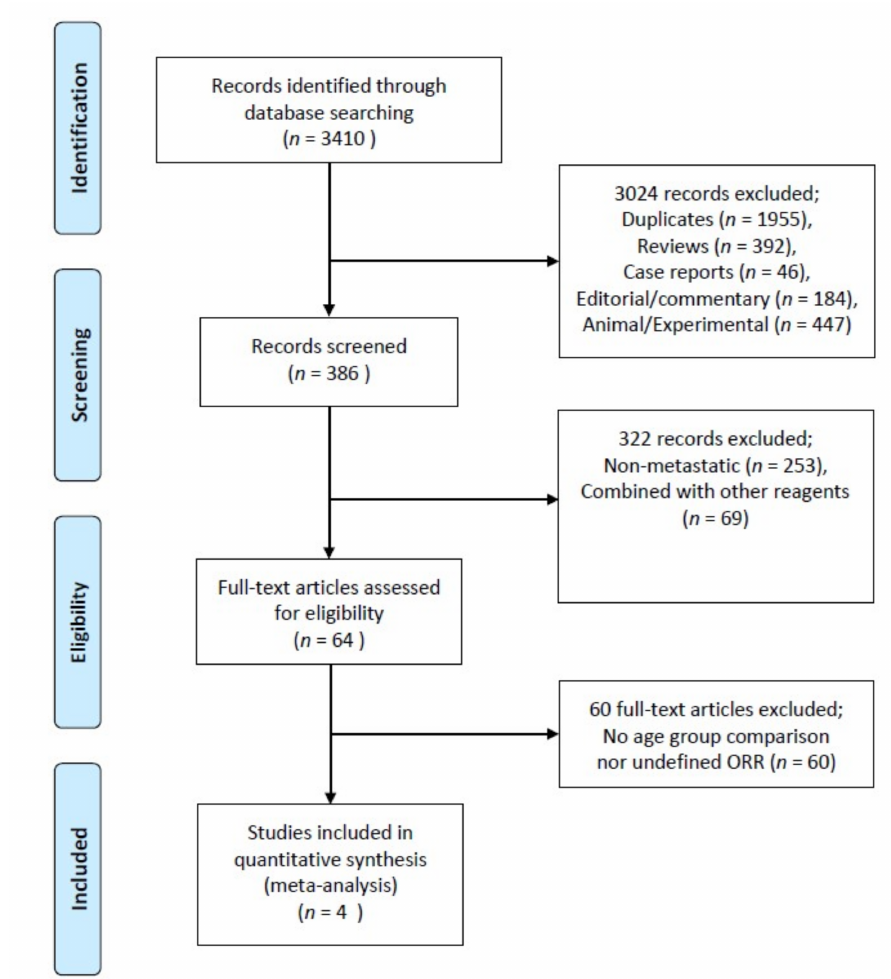
Figure 1. The Preferred Reporting Items for Systematic Reviews and Meta-Analyses (PRISMA) flow diagram of the included